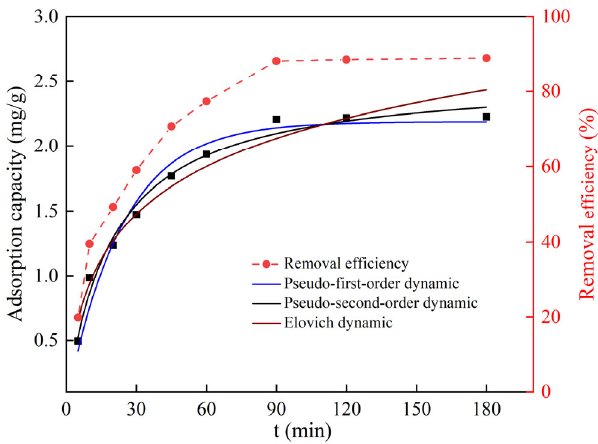
Figure 10. Kinetic fitting of NaOH ‐ CFA on ammonia nitrogen adsorption.